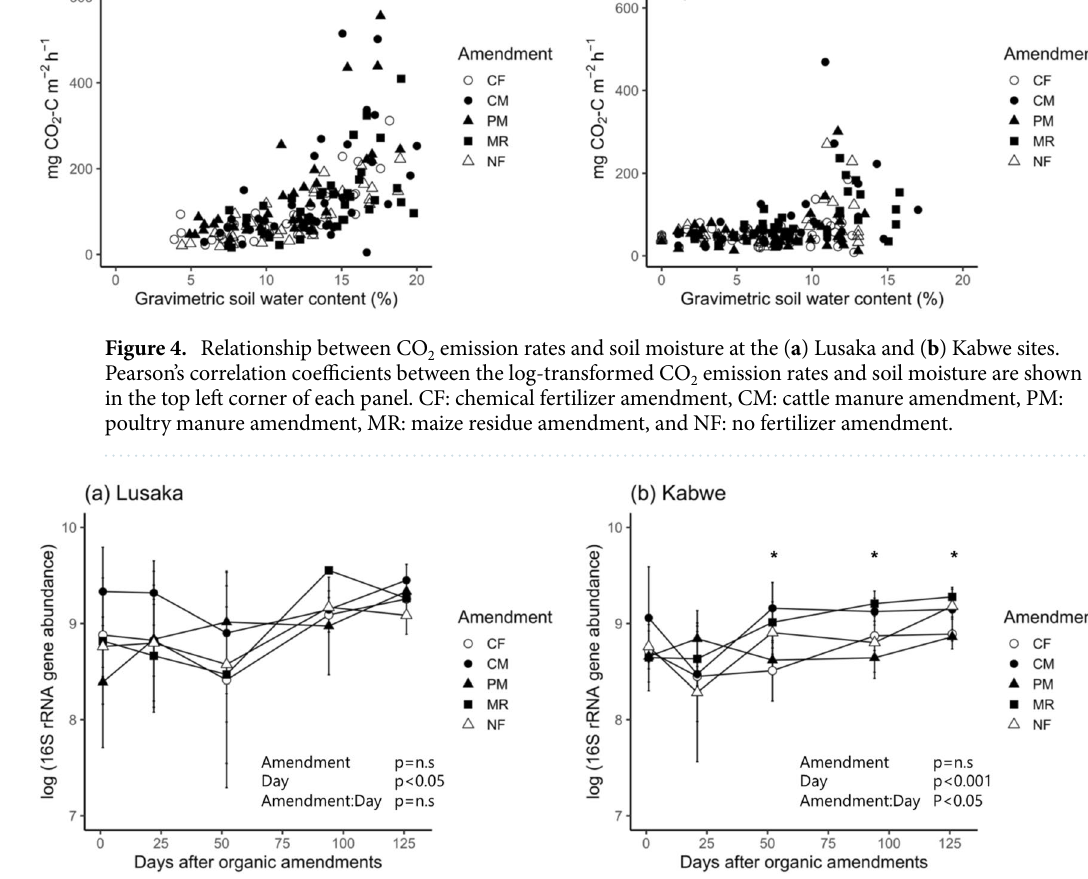
Figure 5. Temporal changes in the prokaryotic abundance at the ( a ) Lusaka and ( b ) Kabwe sites. Different shapes represent different fertilizer treatments. The levels of significance at the bottom of the panels were based on mixed model results for repeated measurements. “ * ” represents p < 0.05 in each sampling period. Error bars represent the standard deviation of the mean ( n = 3). CF: chemical fertilizer treatment, CM: cattle manure treatment, PM: poultry manure treatment, MR: maize residue treatment, and NF: no fertilizer consisted of Chloroflexi and Actinobacteria, which accounted for 27% and 31%, and 21% and 16% of the relative abundances at the Lusaka and Kabwe sites, respectively (Fig. 6). The Lusaka soils had a significantly higher rela- tive abundance of Acidobacteria and Actinobacteria, but a significantly lower relative abundance of Chloroflexi, Firmicutes, and Verrucomicrobia than that in the Kabwe soils (Fig. 6). Nonmetric dimensional scaling (NMDS) showed clear differences between the two sites (Fig. S4). The response of prokaryotic abundance to fertilizer treatments differed between the Lusaka and Kabwe sites throughout the experimental period (Fig. 7). Permutational multivariate analysis of variance (PERMANOVA) showed that fertilizer treatments and sampling time had significant effects on the soil prokaryotic community, but not on the interaction between treatment and time within individual experimental sites (Table S1). At the Lusaka site, CF treatment increased the relative abundance of Firmicutes and decreased that of Acidobacteria (Table S2). Different organic amendments affected the abundance of different phyla at the Lusaka site. For example, the relative abundance of Thaumarchaeota with the CM treatment was higher than that with the MR treatment; Chloroflexi had the highest relative abundance compared to that of the other phyla with the CF, CM, PM, and NF treatments, whereas Actinobacteria had a higher relative abundance than that of the other phyla with the MR treatments during the first 52 days after organic amendment. The relative abundance of Plancto- mycetes gradually increased in all fertilizer treatments until the end of experiment. NMDS plots indicated that the soil prokaryotic community composition at the Lusaka site was more responsive to fertilizer treatments and showed less temporal variation (Fig. S5). Cluster analysis also showed the separation of the CF, CM, and NF treatments from the other treatments (Fig. S6). At the Kabwe site, the soil prokaryotic community responded more to the sampling day points than to the fertilizer treatments. The relative abundances of Thaumarchaeota and Chloroflexi decreased towards the end of the experiment when averaged across all fertilizer treatments (Fig. 7 and Table S3). In contrast, the relative abundances of Acidobacteria, Planctomycetes, and Proteobacteria